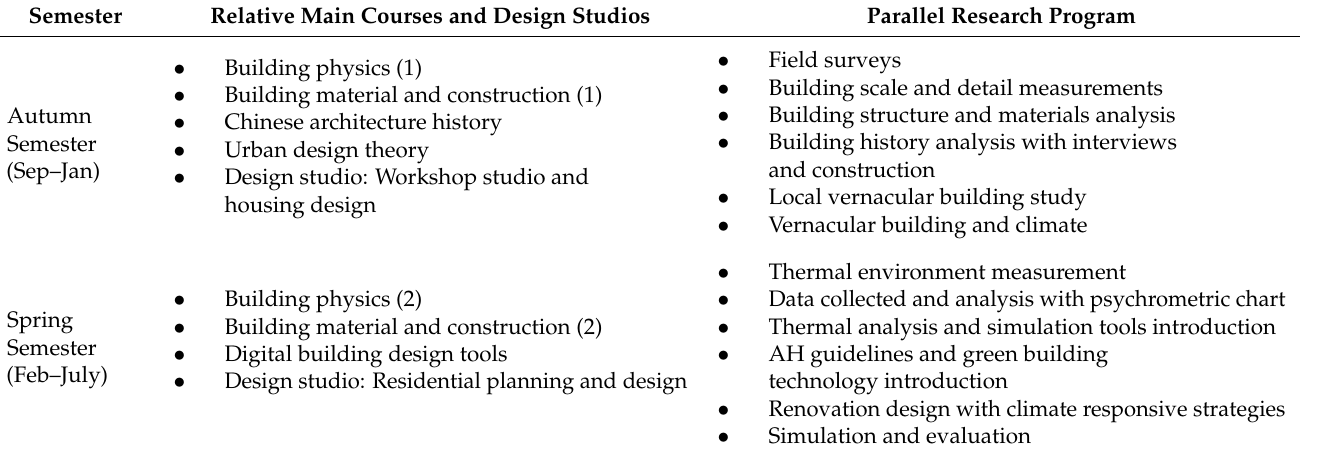
Table 6. Comparison of the research program and the main courses and design